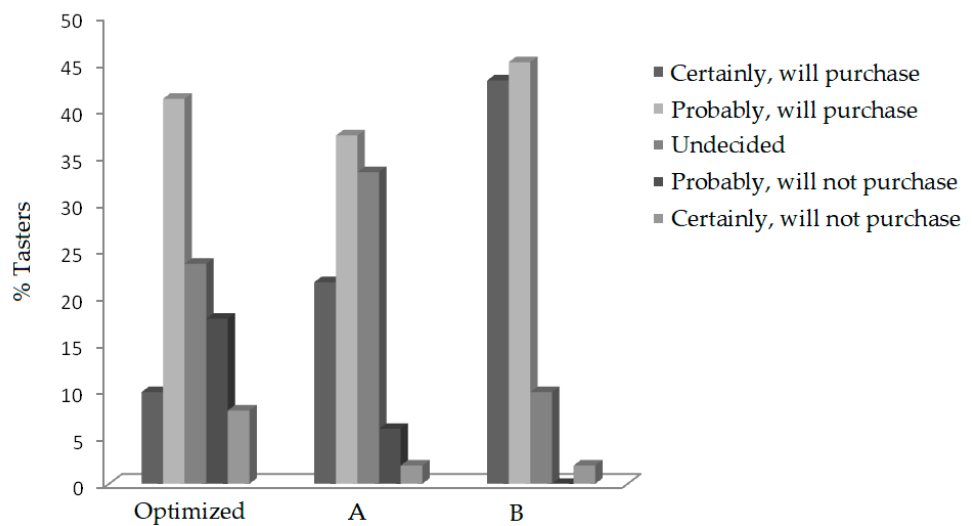
Figure 4. Purchase intention of panelists comparing the optimal cereal bar and the commercialized forms (A and B).